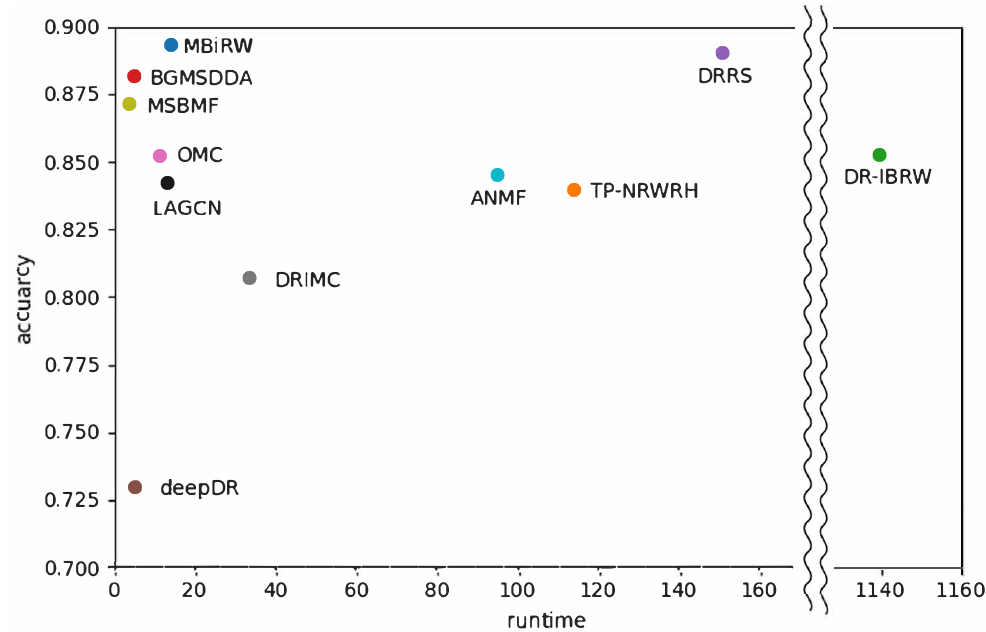
Figure 6. Comparison of efficiency versus accuracy of the selected methods for drug-disease asso- ciation prediction. Runtime was measured when the selected algorithms were implemented on a genome-scale heterogeneous